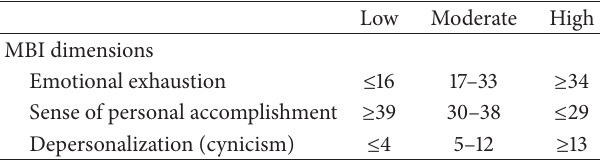
Table 2: Cutoff points and categories of low, moderate, and high levels of burnout per burnout